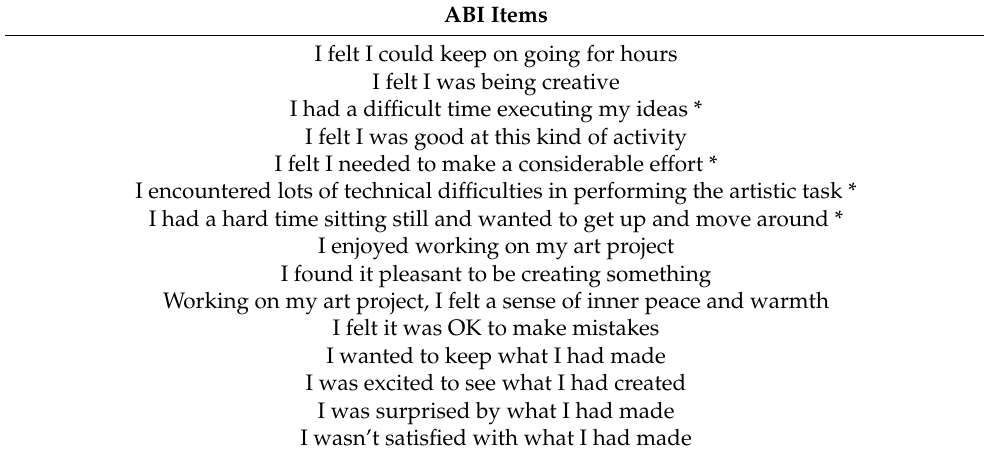
Table 1. ABI-child